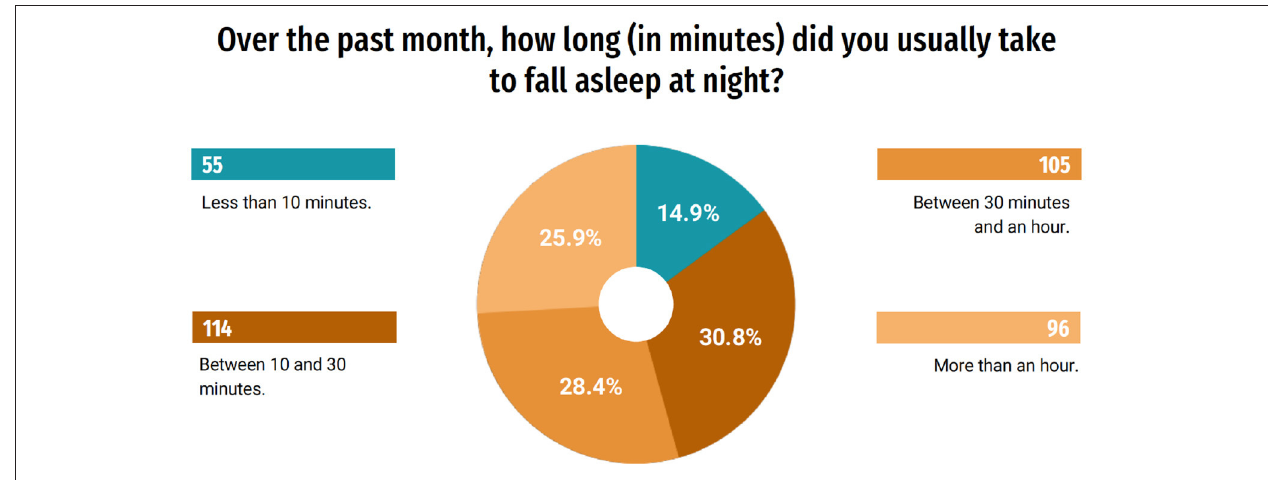
FIGURE 8 | The time it takes to sleep at